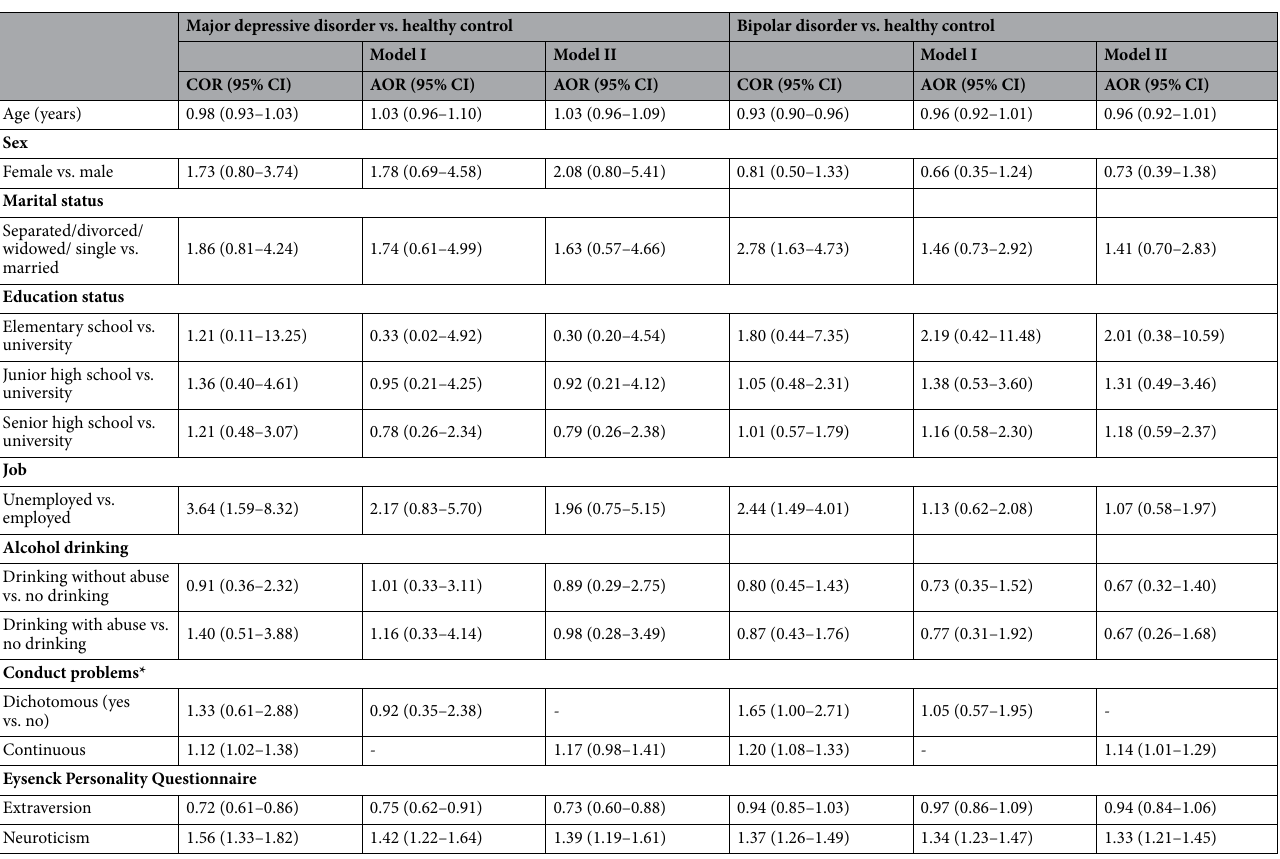
Table 3. Multinomial logistic regression analyses for factors associated with mood disorders. COR crude odds ratio, AOR adjusted odds ratio. *Two definitions of presence of conduct problems were specified into the models separately. In model I, conduct problems were dichotomized by ≥ 3 and < 3 in numbers. In model II, the total numbers of conduct problems were specified into the model as a continuous